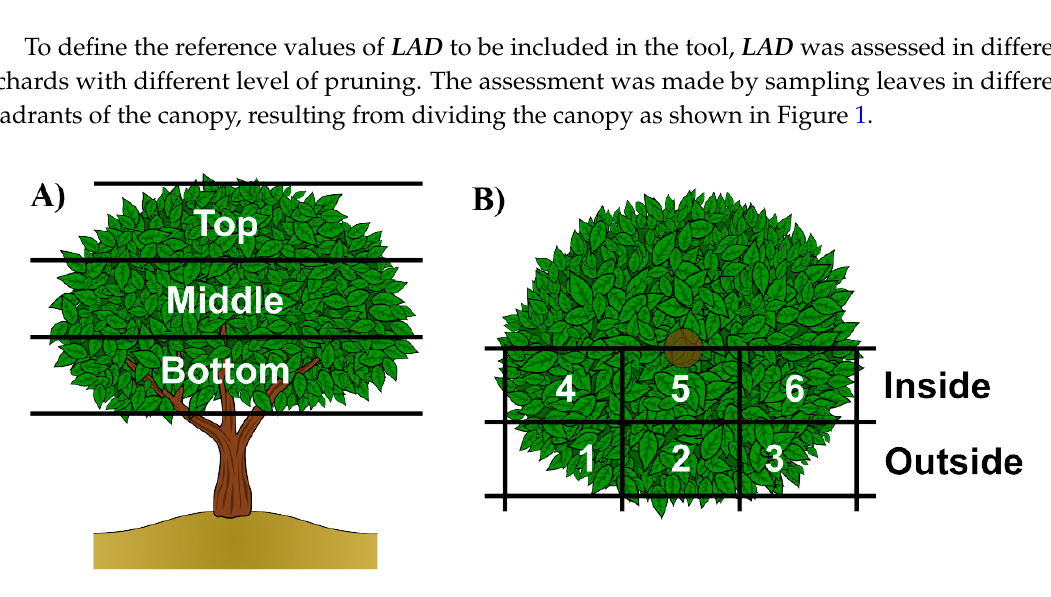
Table 2. Cultivars allocated within each group and the estimated mean values of leaf area density ( LAD ; m 2 leaf/m 3 canopy) for each combination of pruning level and cultivar. Cultivar Examples Included in the Tool